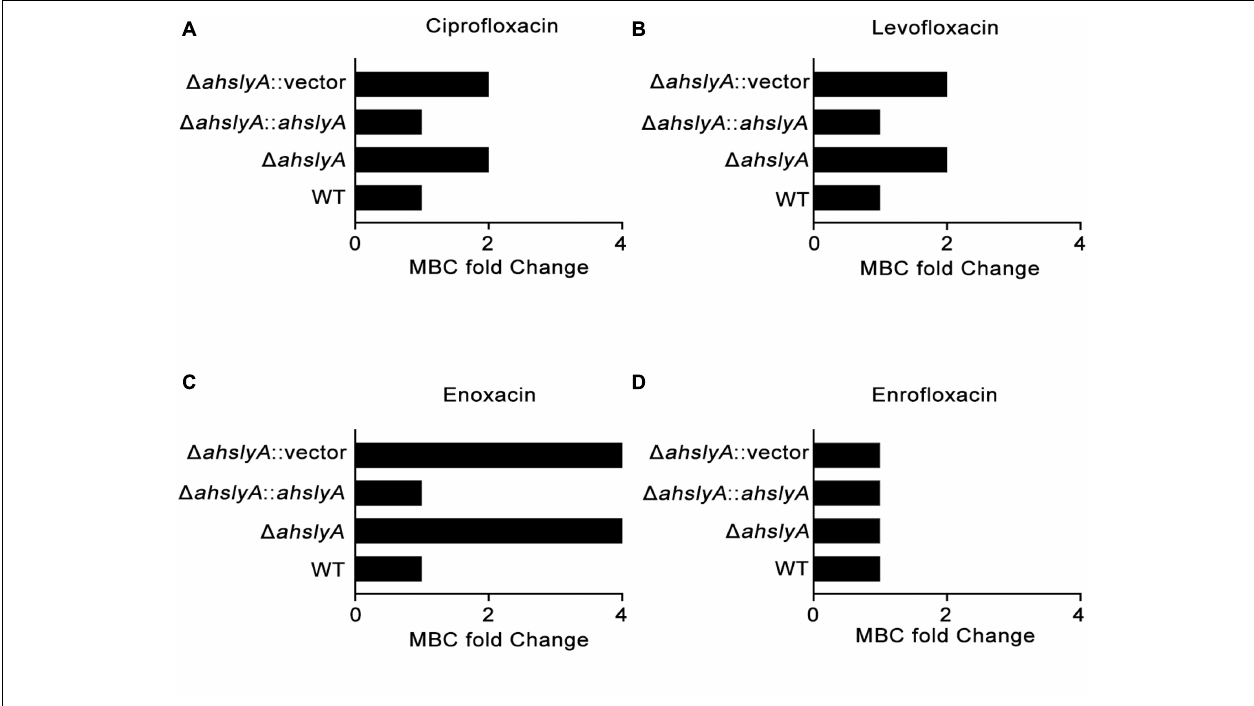
FIGURE 1 | Measurement of the MBCs of ahslyA derivatives in A. hydrophila to four quinolone antibiotics. (A) The MBCs of (cid:49) ahslyA and complemented (cid:49) ahslyA strains, in addition to WT and (cid:49) ahslyA carrying an empty vector as negative controls, were tested for their sensitivity to (A) ciprofloxacin, (B) levofloxacin, (C) enoxacin, and (D) enrofloxacin. The MBCs of each strain to antibiotics were compared with WT as MBC fold